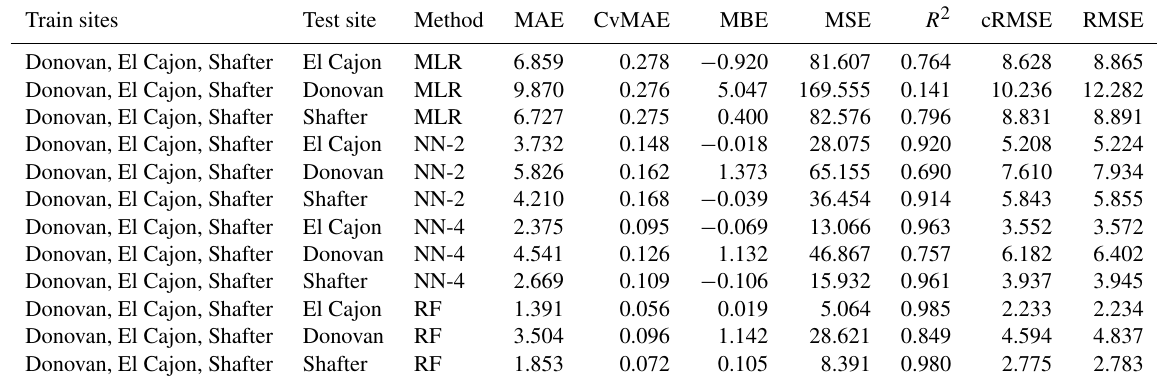
Table C16. Level 3 test results for O 3